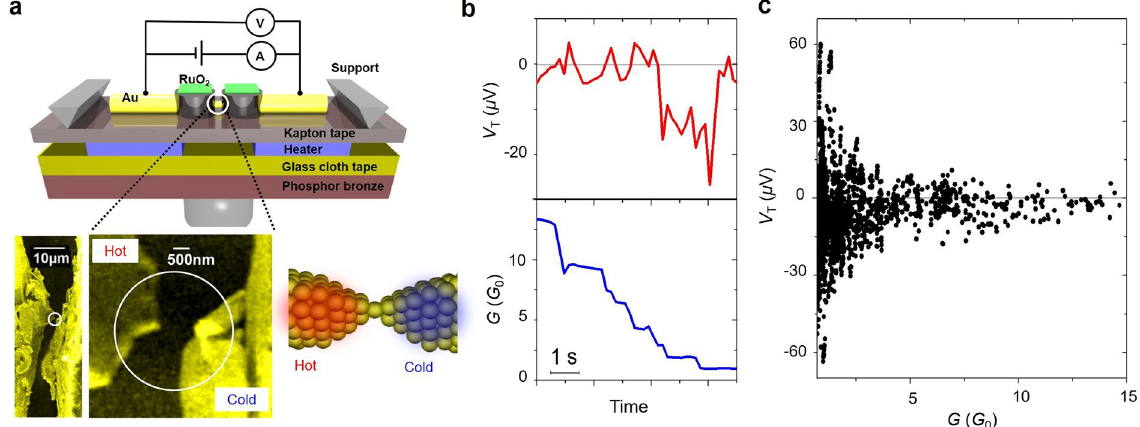
Figure 1. Thermoelectric voltage and simultaneous conductance measurements. ( a ) Schematic view of the MCBJ setup used for the simultaneous measurement of the conductance and thermoelectric voltage of the Au atomic junction. The Pt micro heaters and the RuO 2 thermometers are placed on each side of the contact: Inset: Scanning electron microscope image of Au contact after it is broken. ( b ) Conductance and thermoelectric voltage of the Au atomic junction during stretching of the contact. The temperature difference was 16 K and average temperature was 27 K. ( c ) Distribution of the thermoelectric voltage of the Au atomic junction as a function of conductance of the contact. The distribution is constructed from the combined data of 60 individual